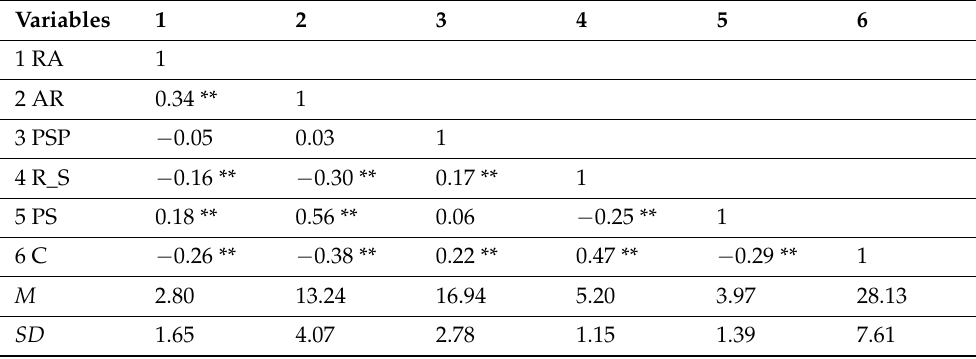
Table 1. Descriptive statistics and correlations among study